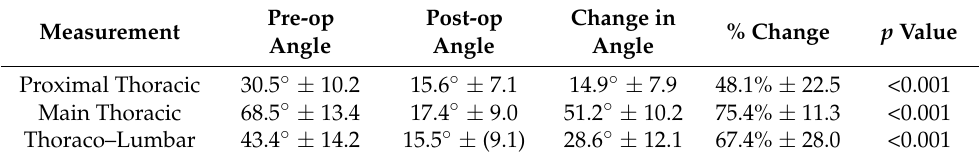
Table 2. Coronal plane curve correction.